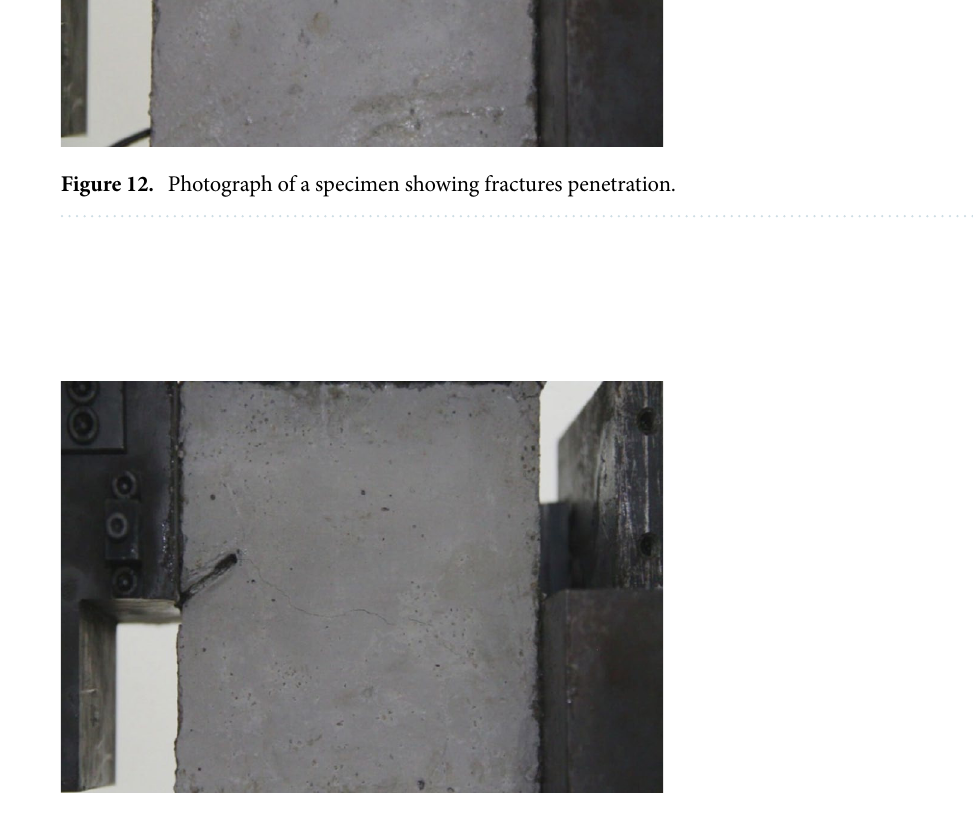
Figure13. Photograph of a specimen showing fractures